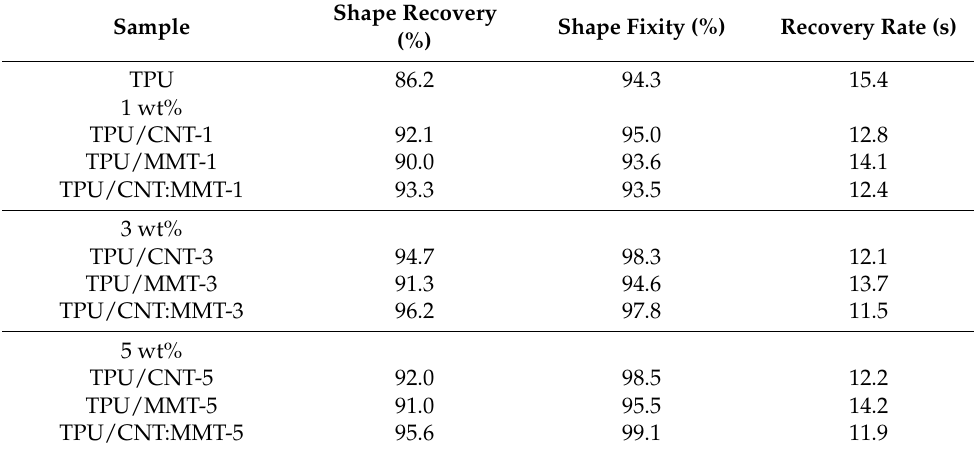
Table 2. Shape memory performance of the composites (Reproduced with permission from Elsevier, 2020).